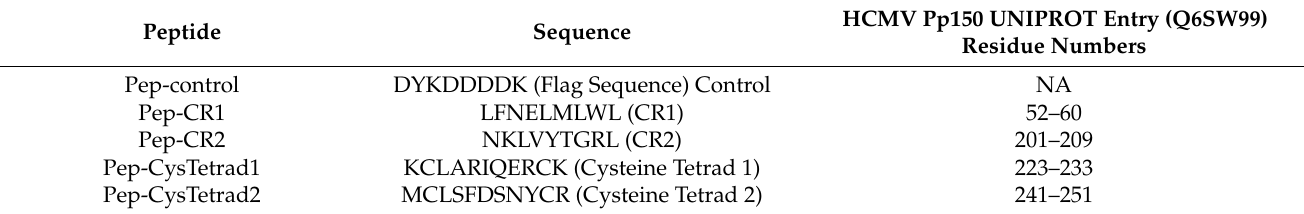
Table 1. Amino acid sequence of test and control peptides 1 .